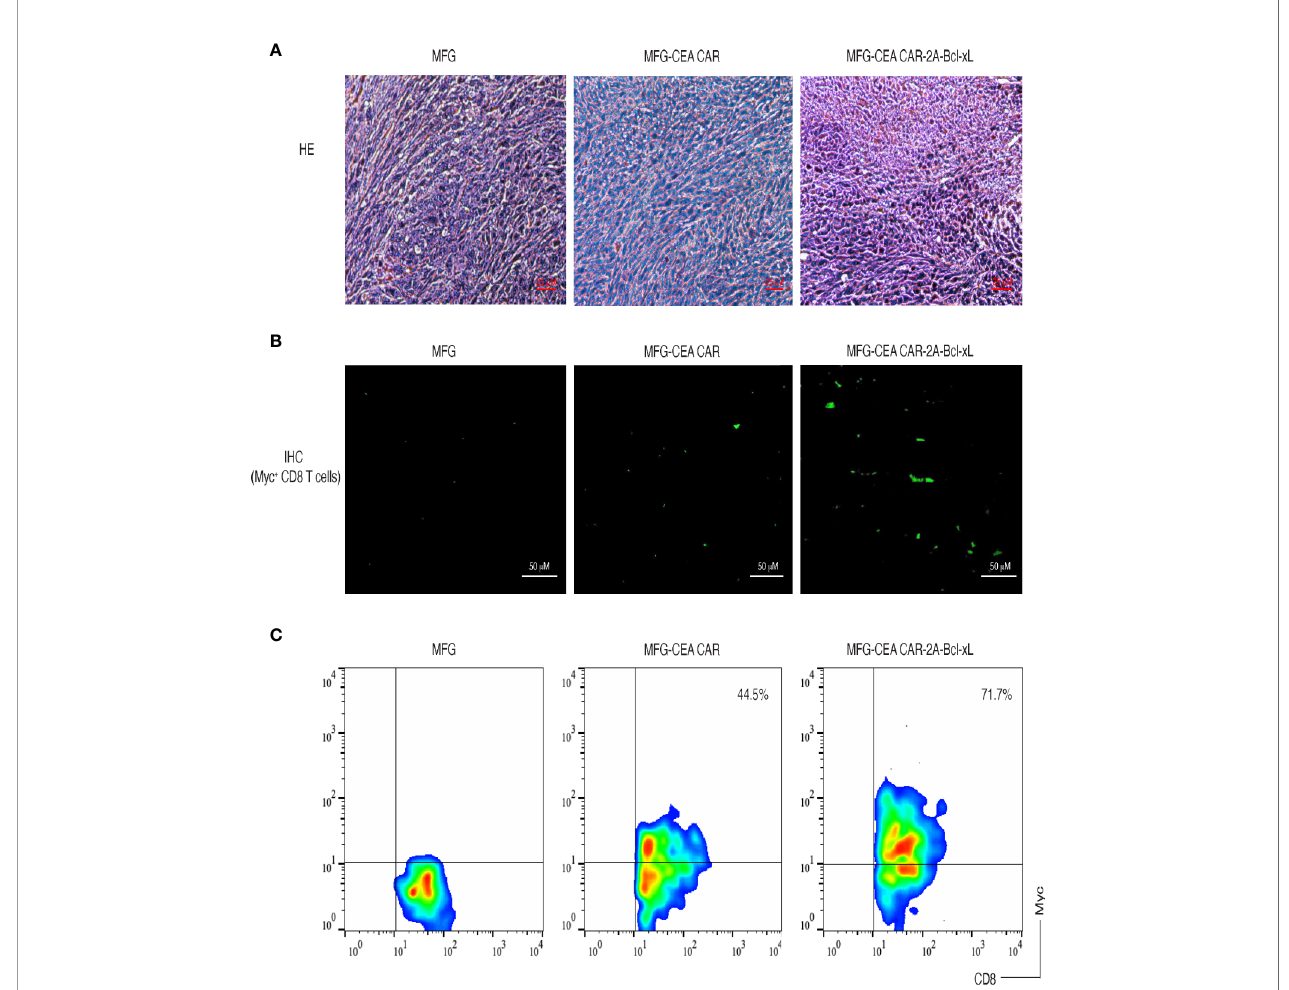
FIGURE 6 | Carcinoembryonic antigen (CEA) chimeric antigen receptor T (CAR-T) cells overexpressing Bcl-xL prominently accumulated in tumor tissues. C57BL/6 mice were adoptively transferred with CEA CAR-T cells expressing with or without Bcl-xL or control cells one week after the mice were s.c. injected in the fl ank region with MC-38 or MC-32 tumor cells. On day 21 to 22 after tumor challenge, tumor tissues were examined for tumor-reactive T cell in fi ltration. (A) H&E staining (scale bars: 25 m m). (B) Immunohistological staining (scale bars: 50 m m). Myc + CEA CAR-T cells (green) in fi ltrated in tumor tissues (the dark background). (C) Single- cell suspensions from tumor tissues were analyzed for expression of CD8 + and Myc + T cells by fl ow cytometry, after gating on the CD8 + population. Data are representative of three independent experiments.